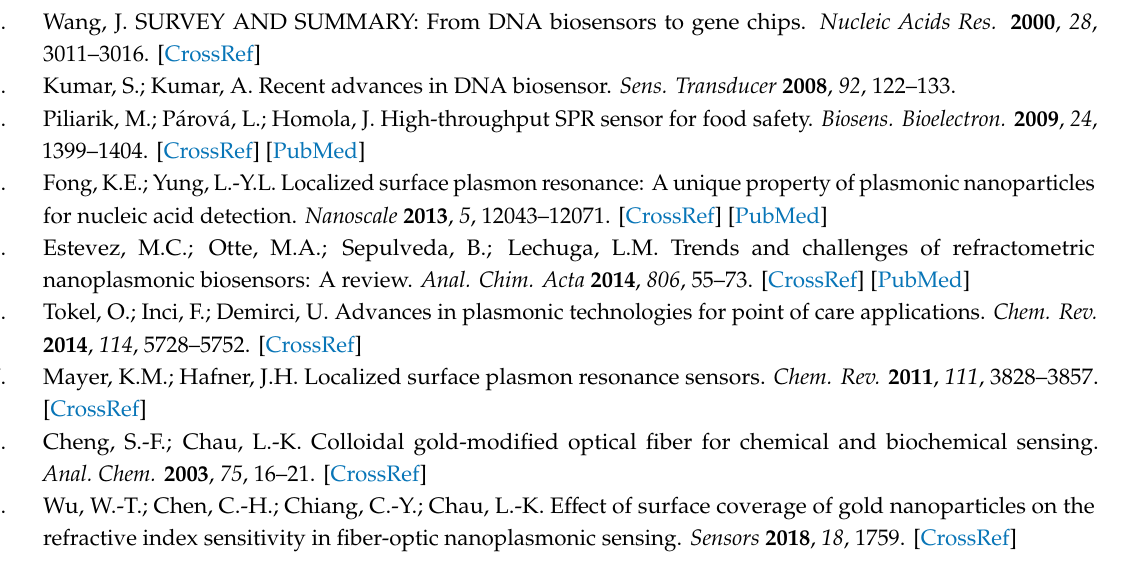
s1, Figure S1: AuNP images obtained from electron microscopy, Figure S2: UV-visible spectra of thiolated ssDNA / MCE-modified AuNPs on glass slides before and after DNA hybridization with various MCE reaction time, Table S1: Normalized absorbances of thiolated ssDNA / MCE-modified AuNPs on glass slides before and after DNA hybridization with various MCE reaction